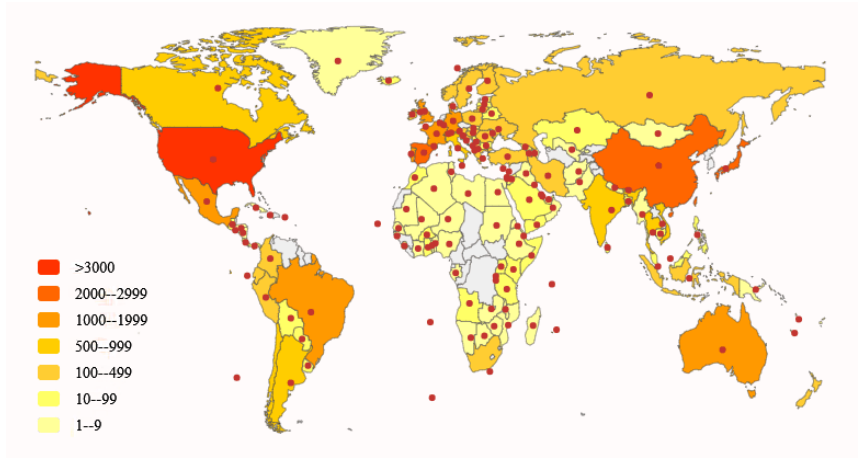
Figure 3. The distribution and number of project